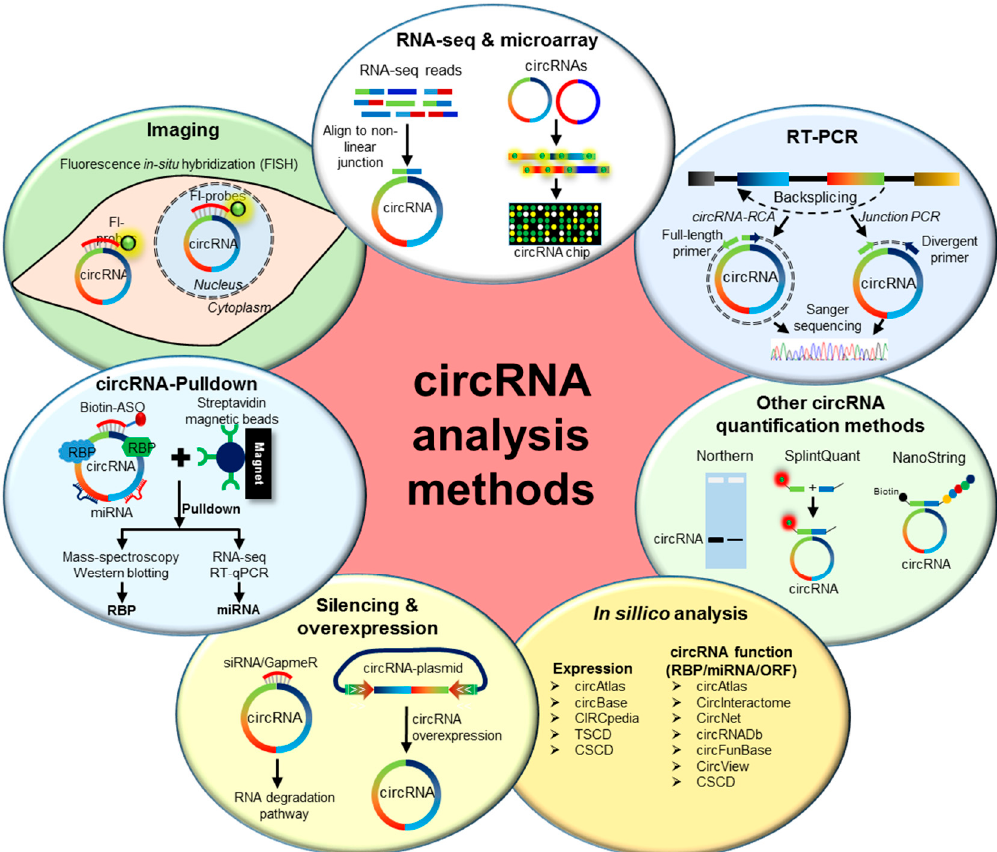
Figure 1. Schematic representation of different methods for circular RNA analysis. (From top clockwise) RNA-seq and circRNA microarrays are used for the genome-wide identification and quantification of circRNAs. RT-PCR of circRNA using the divergent and full-length primers across the backsplice junction, followed by Sanger sequencing, confirms the expression of specific circRNA. In addition, divergent primer PCR can be used for circRNA quantification. Other methods, such as northern blotting, SplintQuant, and NanoString can be used for the quantification of circRNAs. Several databases and web-tools have been developed for the in silico analysis of circRNA expression and function. Loss-of-function analysis for circRNA can also be performed using siRNA/GapmeR for circRNA silencing, while gain-of-function analysis can be achieved by overexpressing the circRNA of interest using a plasmid vector. The circRNA-associated cellular miRNAs and RNA-binding proteins (RBPs) can be analyzed by performing circRNA pulldown assays using antisense oligo-targeting circRNA junctions. Finally, circRNAs can be visualized in the cells using fluorescent-tagged probes targeting the backsplice junction of target circRNA.